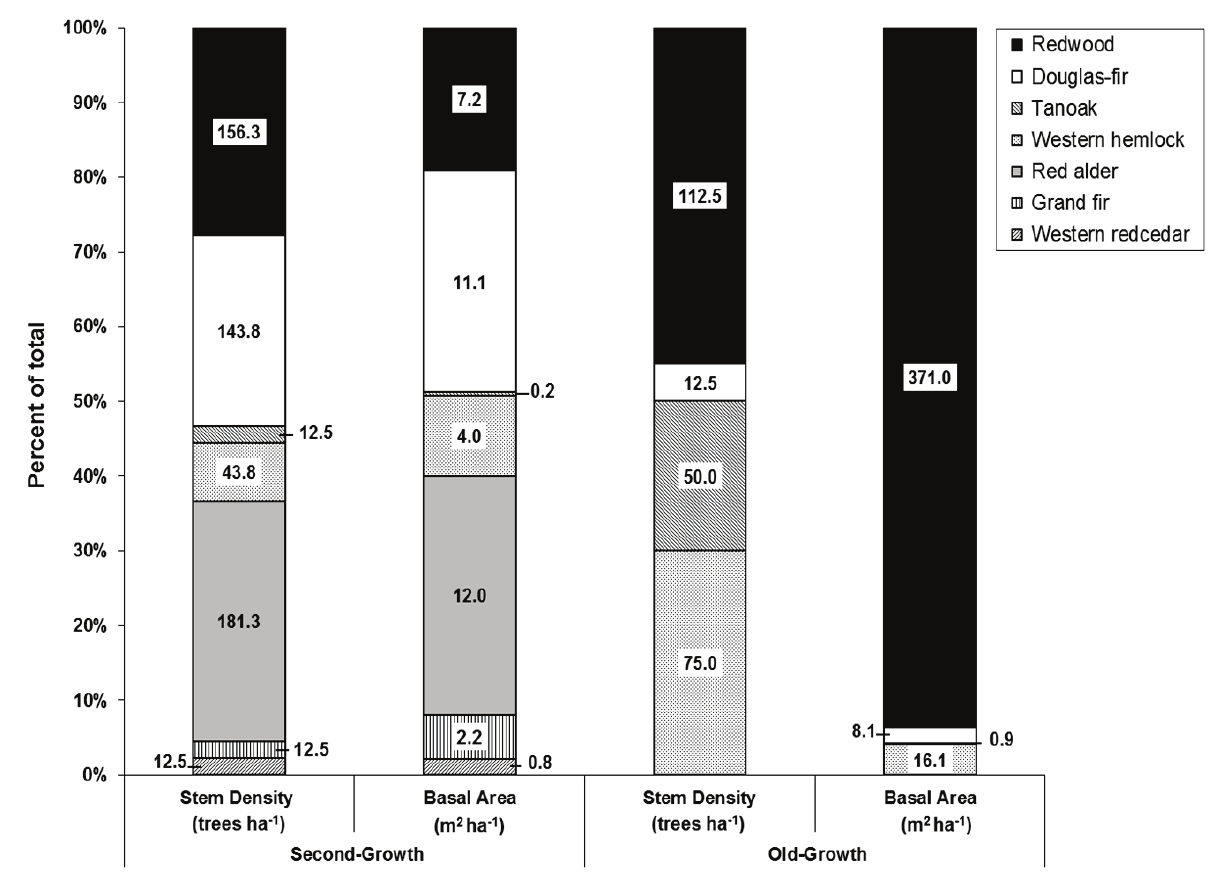
Figure 2. Percent total basal area and stem density by species for adjacent old-growth and second-growth riparian stands (Redwood National Park, USA). Numbers indicate actual basal area or stem density; residual old-growth redwoods (second-growth)